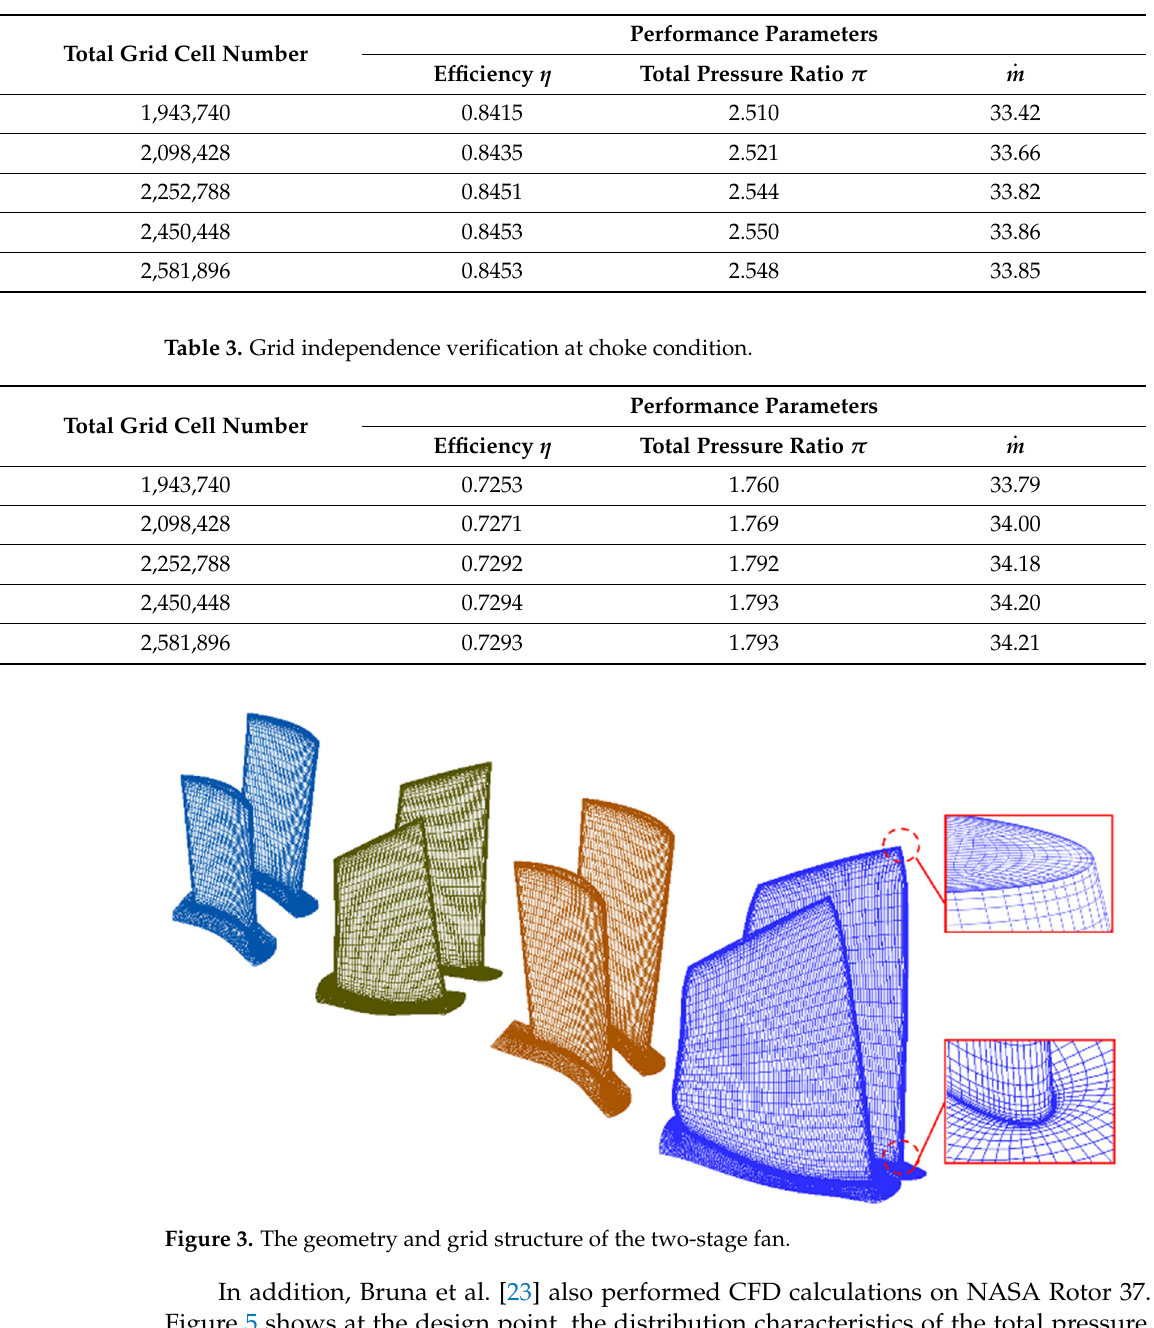
Table 2. Grid independence verification at the design point.